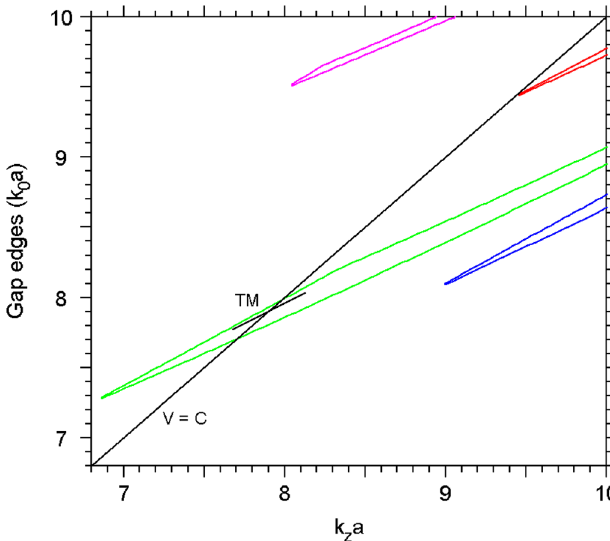
FIG. 11. Band gap diagram of the 4 : 9 (cid:3) m -period fiber (defect R=a ¼ 0 : 53 , lattice hole r=a ¼ 0 : 33 ) fabricated by Incom Inc. showing location of TM accelerating mode as calculated with BANDSOLVE .